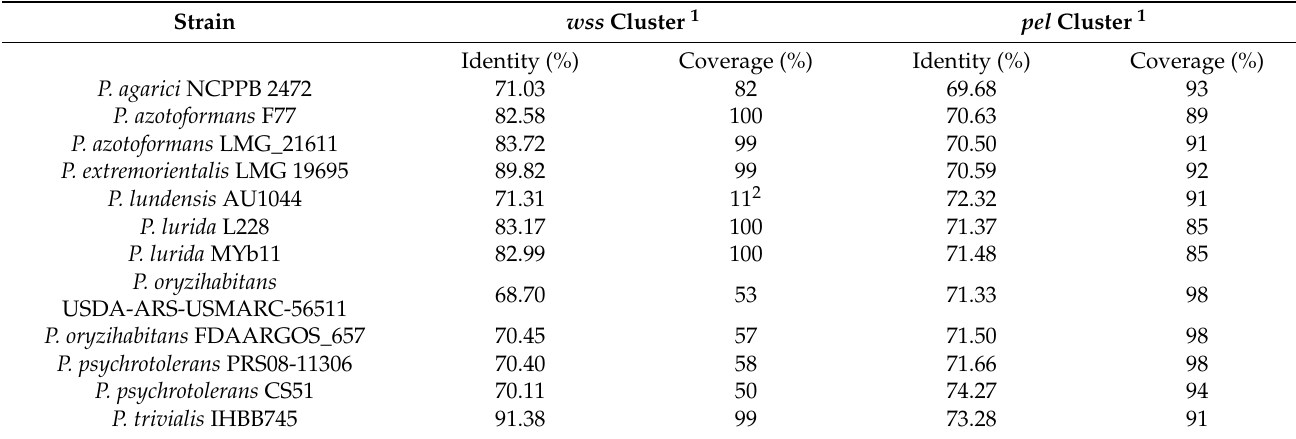
Table 2. Pseudomonas spp. strains obtained from Blanco–Romero et al., (2020) that have been reported to contain the wss and pel